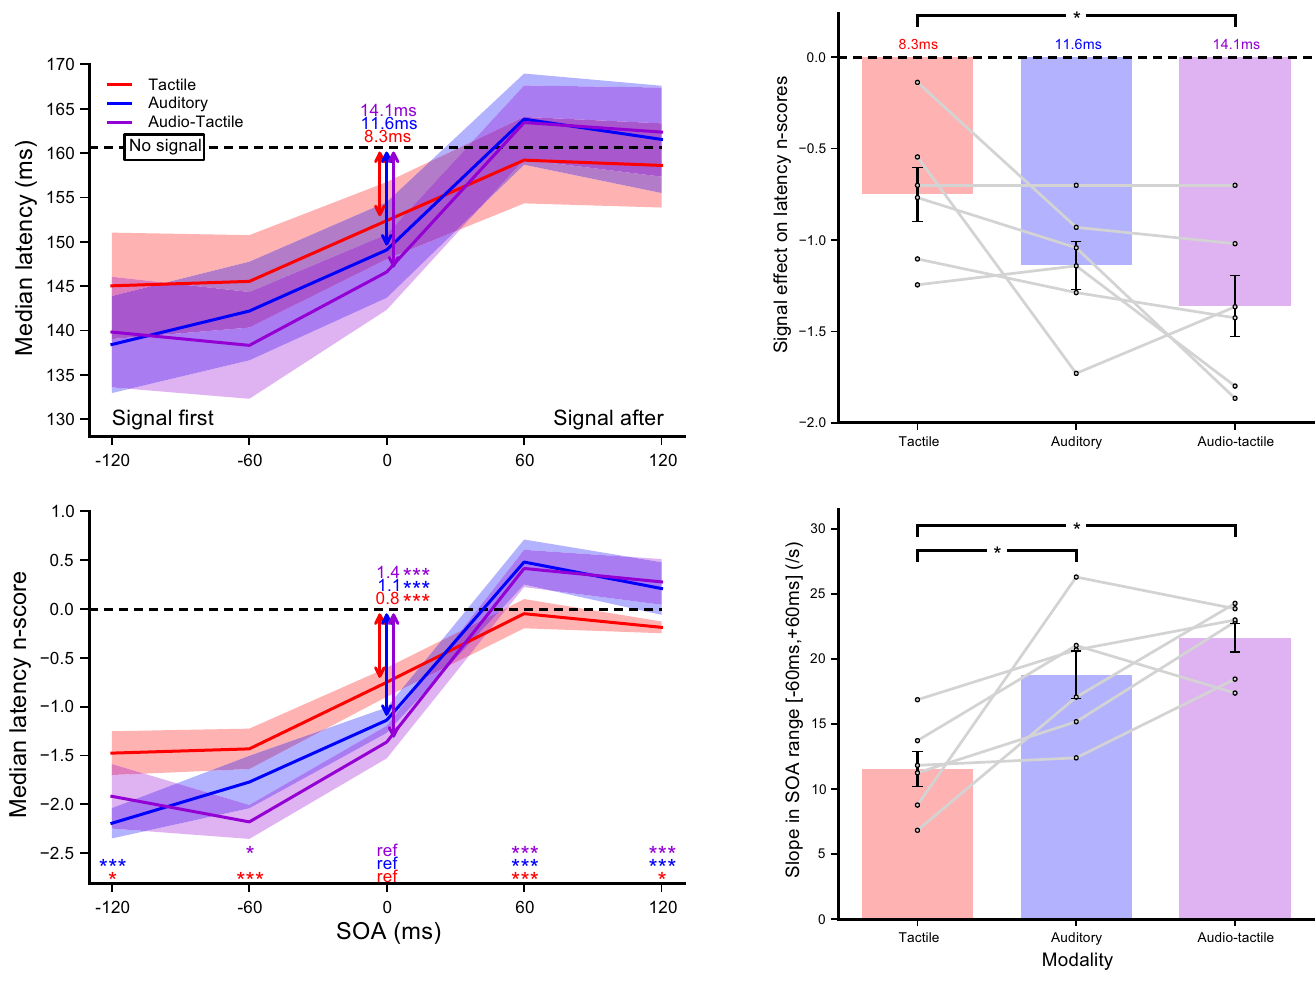
Fig 7. Experiment F. Effect of tactile, auditory and audio-tactile stimulation on saccade onset. (Left panel) Median latencies averaged across participants for each SOA condition (top) and their corresponding n scores (bottom). Dashed lines show the No signal condition level. Statistics performed on the n scores for each modality separately included a single sample t-test to compare the SOA = 0 ms reference condition with the No signal condition (colored arrows), and paired t-tests comparing this reference with each SOA condition (colored stars for each SOA above the X-axis). (Top-right) Average signal effect on latency n scores for each modality when SOA = 0 ms. (Bottom-right) Average slopes of the n scores linear regressions computed for each modality within the range [ − 60 ms, +60 ms]. Grey lines show individual results and error bars indicate inter-individual SEM. Comparisons were done using paired t-tests. Three stars indicate highly significant differences after Bonferroni correction (p < 0.01) while single stars significant differences without correction (p <